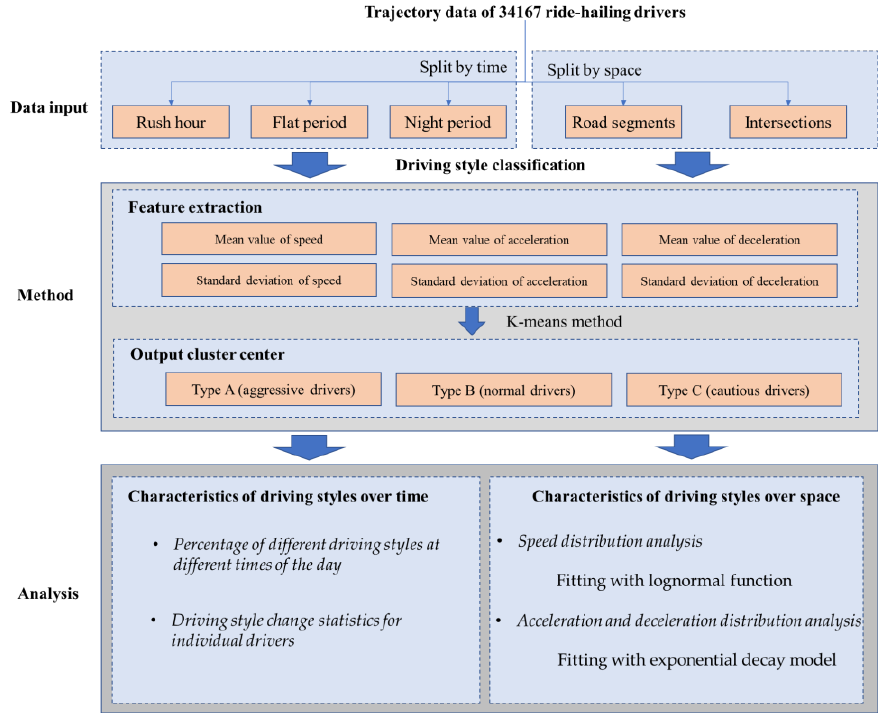
Figure 4. Flowchart of the research.